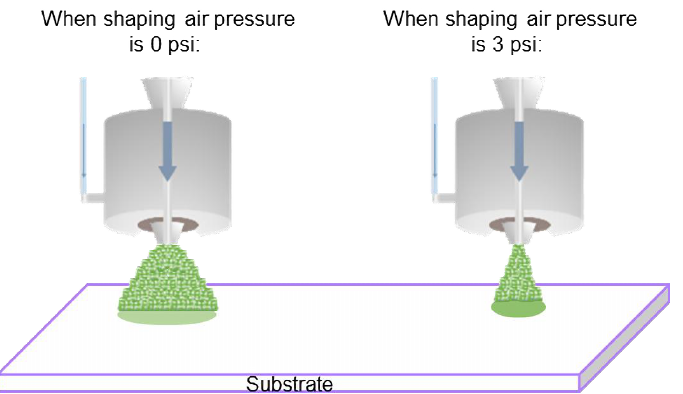
Figure 9. Schematic illustration of the resulting flow ( left ) without shaping air and ( right ) with shaping air.